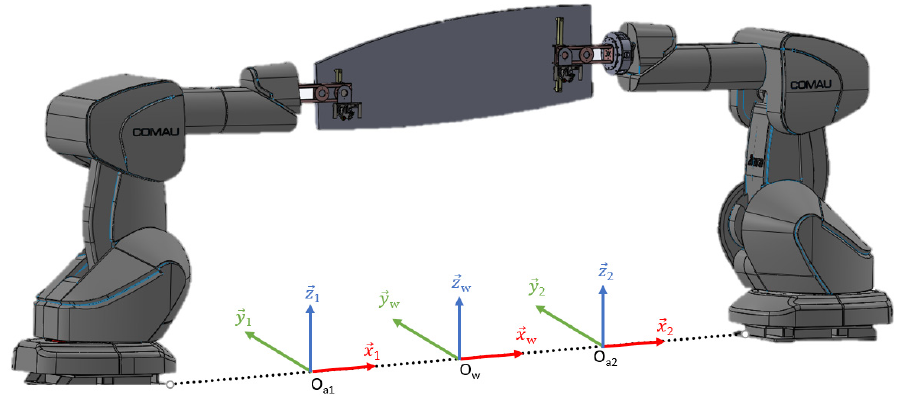
Figure 8. A common reference defined by projecting each auxiliary reference.